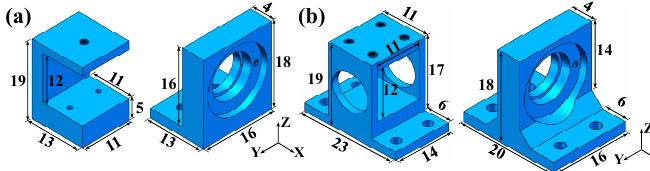
Figure 4. Fixed mounts of PBS and FL in ( a ) the original sensor and ( b ) optimized sensor.